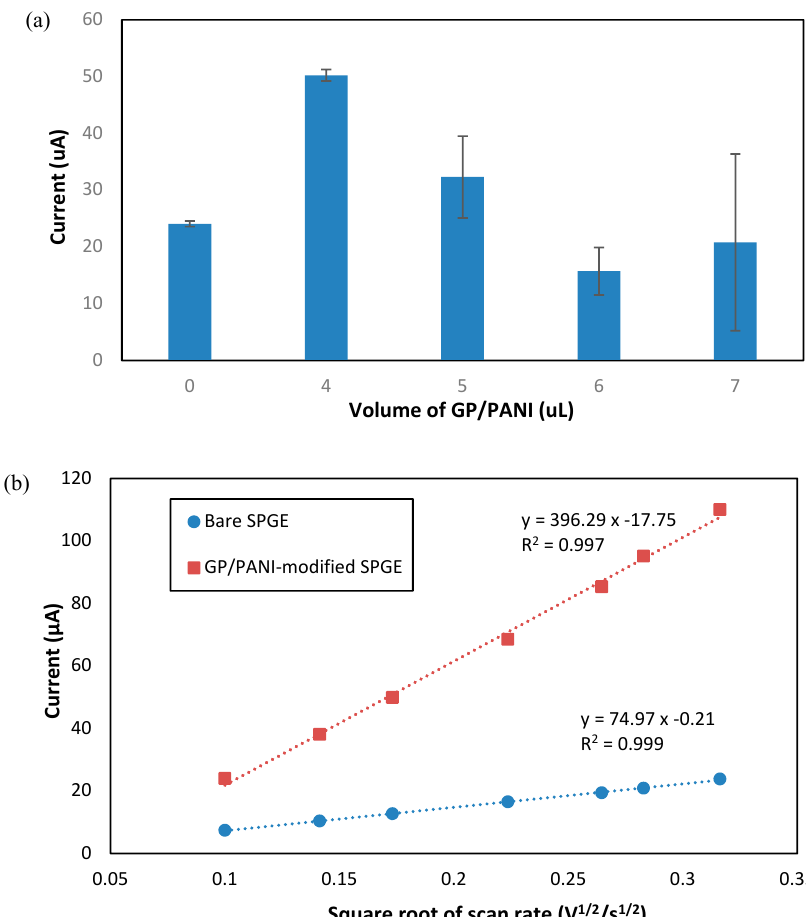
Figure 4. ( a ) Histogram of different amount of GP/PANI ( µ L) on SPGE. ( b ) The relationship of oxidation peak current and square root of scan rates for bare SPGE and GP/PANI-modified SPGE.